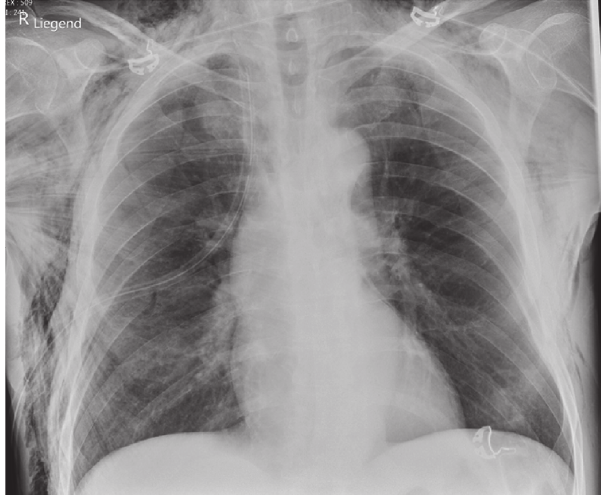
Figure 4: Chest X-ray after insertion of thorax